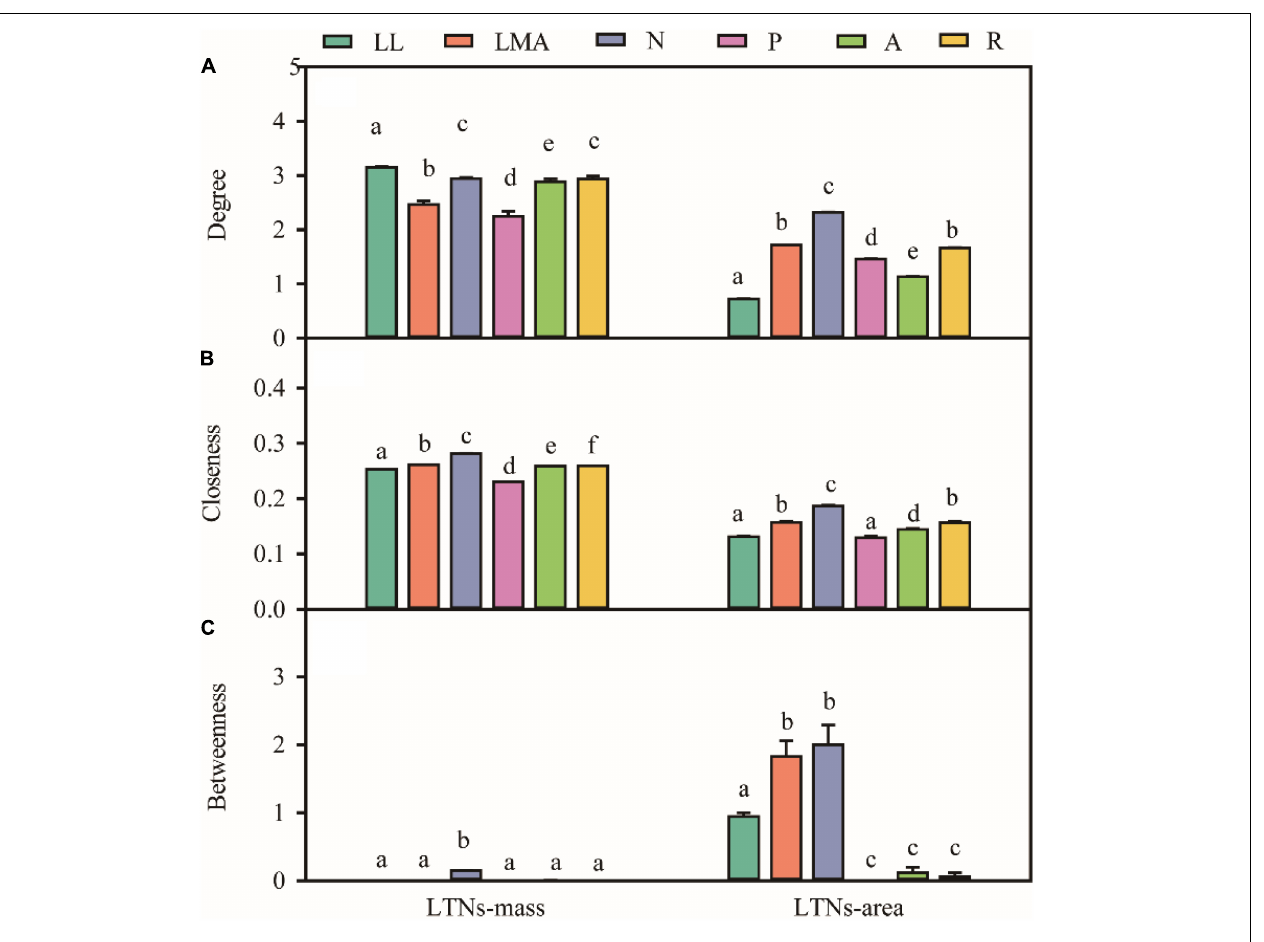
visualization of interdependent relationships among